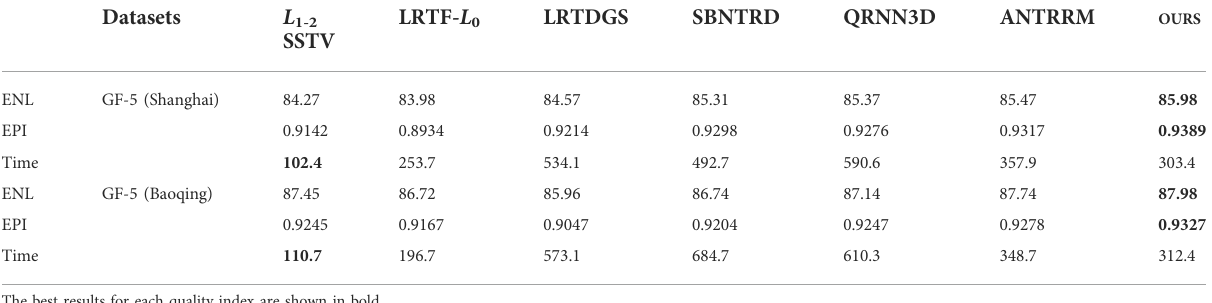
TABLE 2 Quantitative comparison of all competing methods on the two GF-5 datasets (time unit: second).